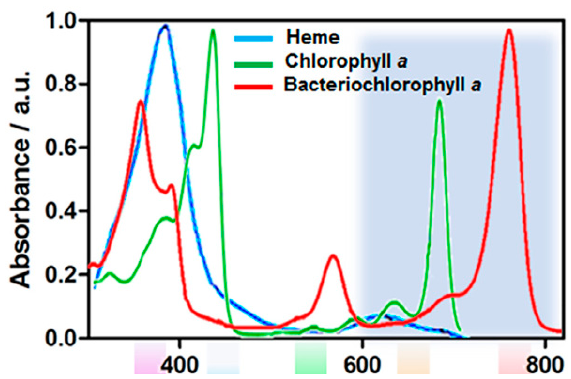
Figure 5. UV-vis absorption spectra of tetrapyrrolic macrocycles that are involved in natural processes. Reprinted from Pucelik et al. [8] with permission (open access) from Elsevier,